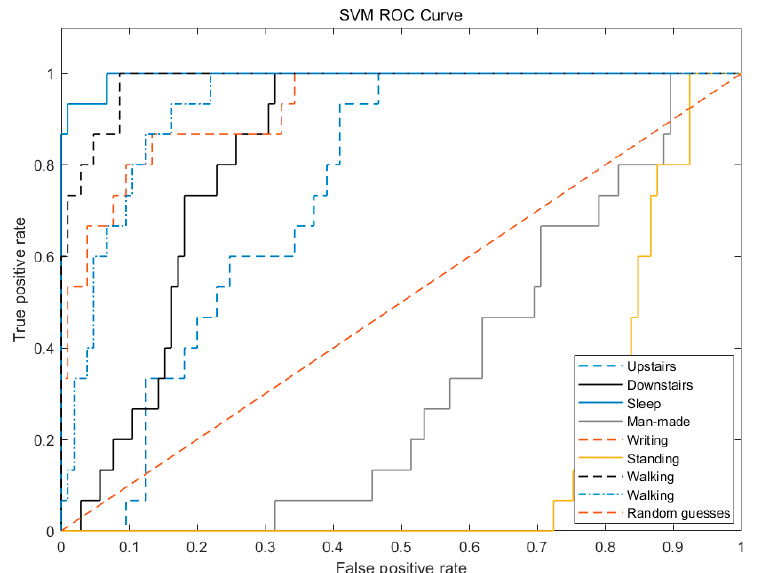
Figure 9. SVM ROC curve.